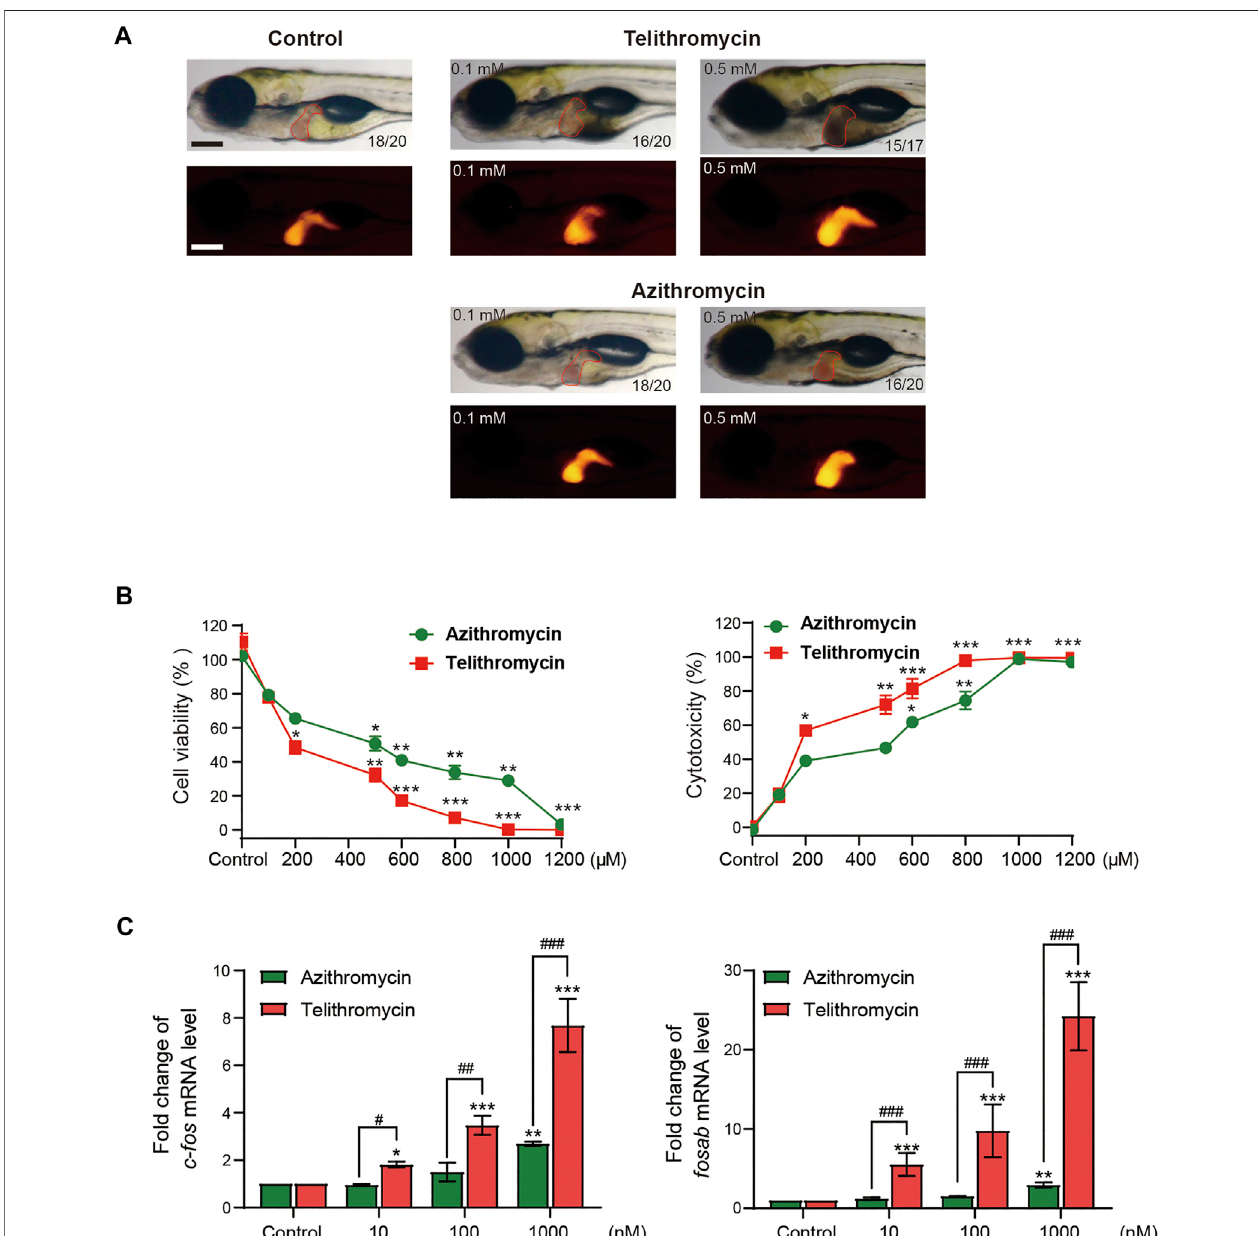
FIGURE 2 | Toxicity of telithromycin and azithromycin in zebra fi sh liver and human liver cells. (A) Visual liver phenotype of zebra fi sh larvae at 6 dpf treated with telithromycin and azithromycin and imaged by a light microscopic (red outline) and a fl uorescence microscopic (red fl uorescence). The digit on the bottom right corner indicates theratioofpositiveimages. Scalebar,250 μ m. (B) Cytotoxicityoftelithromycinand azithromycinonhumanL02 cellsbyusingthe CCK-8 kittotestcell viability and the LDH activity assay kit to detect cell cytotoxicity. (C) Expressions of the human c-fos gene were examined by qRT-PCR analysis in telithromycin and azithromycin treatment groups. Control, 0.1% DMSO-treated group, * indicates p < 0.05, ** indicates p < 0.01, *** indicates p < 0.001 compared to control group; # indicates p < 0.05, ## indicates p < 0.01, ### indicates p < 0.001 compared to the azithromycin group at a same concentration. All statistical data are given as mean ± SD ( n =